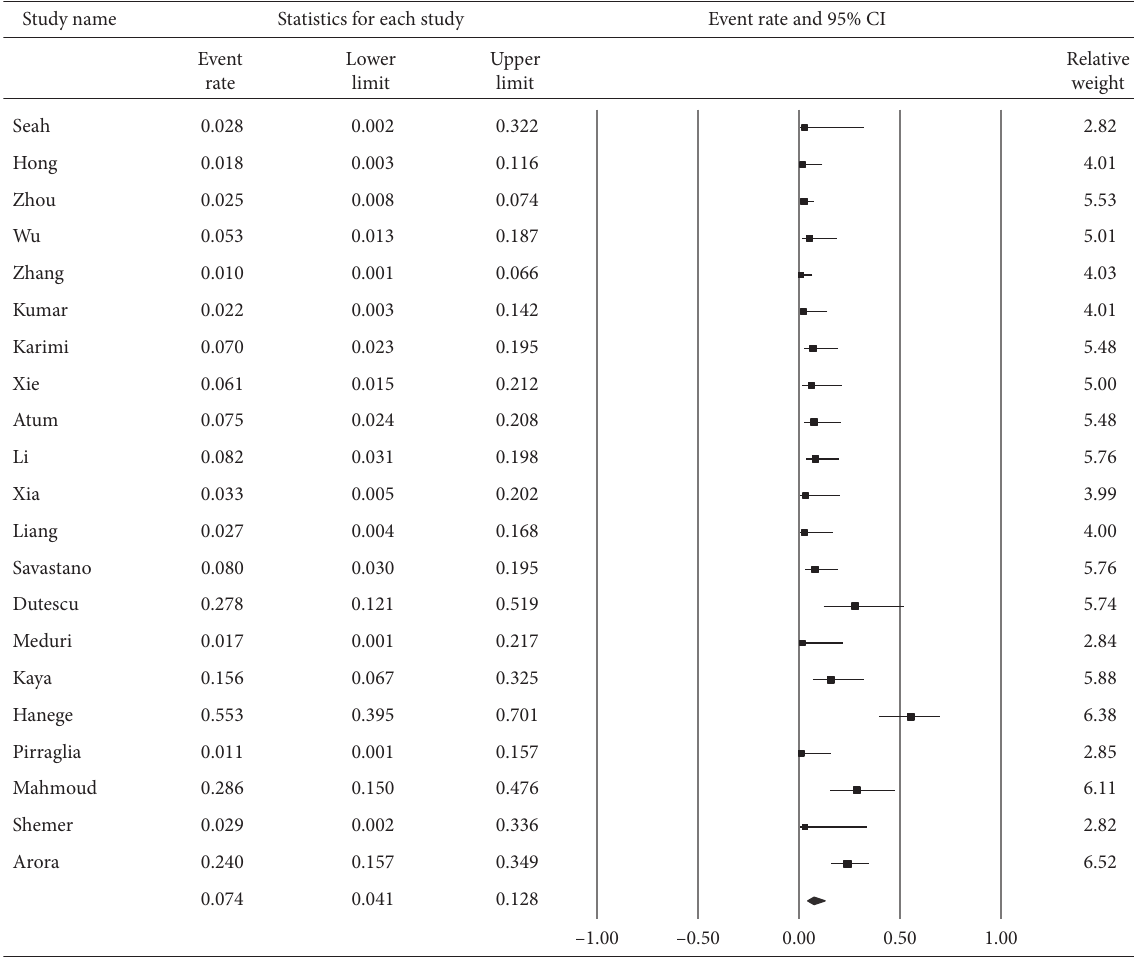
Figure 3: The overall positive rate of RT-PCR for SARS-CoV-2 in conjunctival/tear samples.